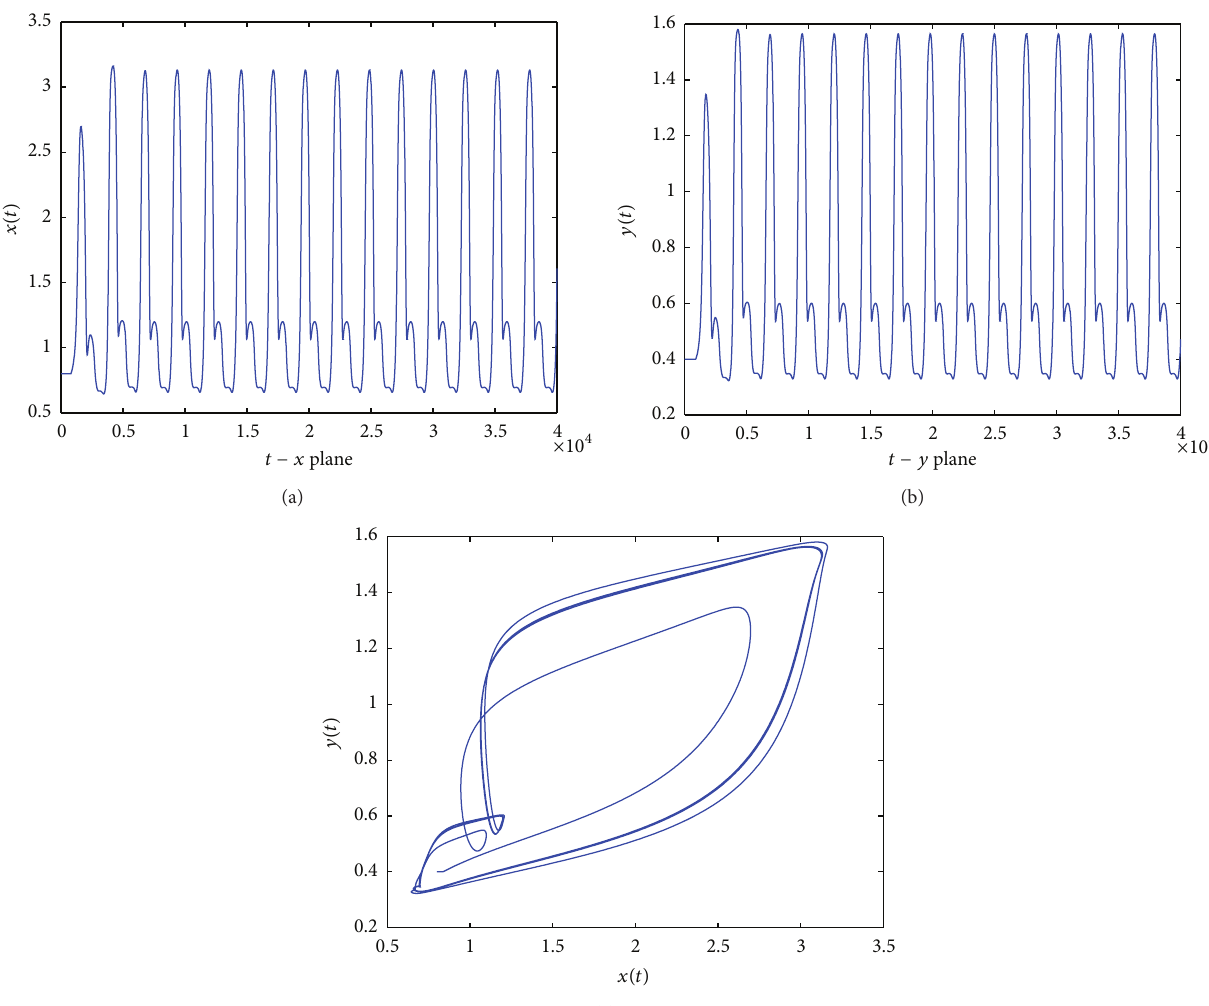
Figure 5: The trajectories and phase graphs of system (1) with 𝜏 = 𝜏 1 + 𝜏 2 = 10 + 60 = 70